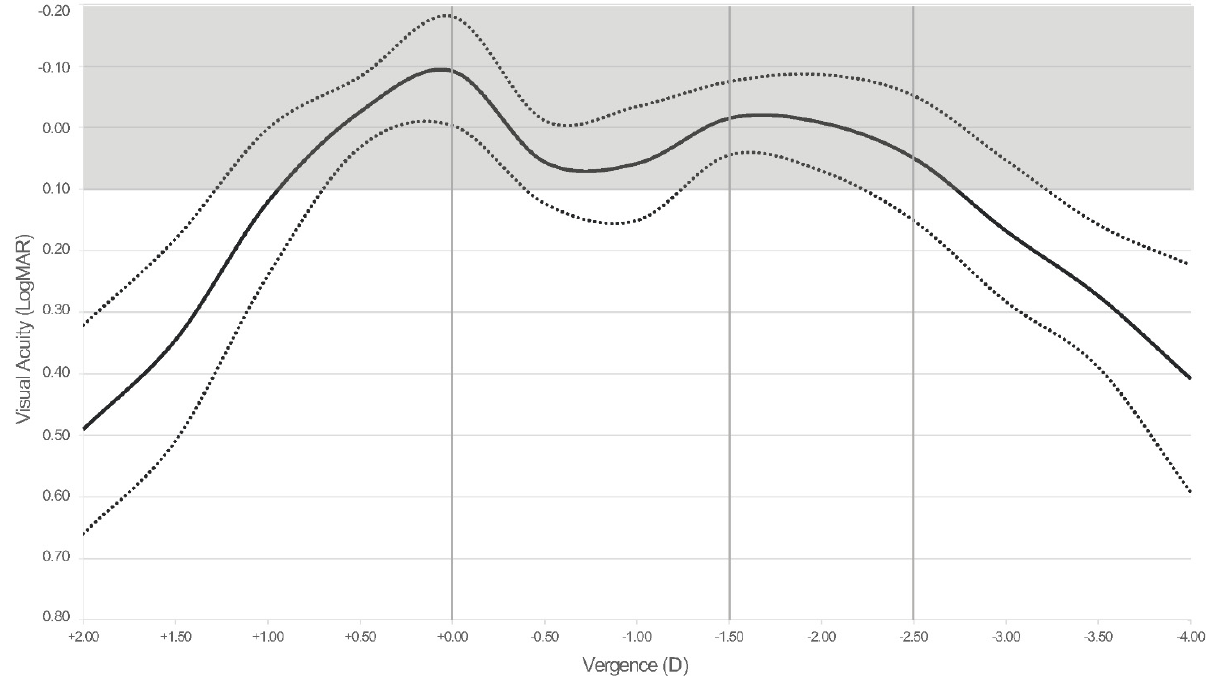
Figure 4. Average defocus curve 3 months after intraocular lens implantation ( n = 50 eyes, 25 patients). Dotted curves represent the ± standard deviation curves. For reference purposes, dashed vertical grey lines highlight the location of far, intermediate (67 cm), and near vision (40 cm) on the vergence axis, and the grey shadowed area highlights that area on the chart corresponding to visual acuity values above 0.1 logMAR (equivalent to 1.0 Snellen decimal or 20/20).